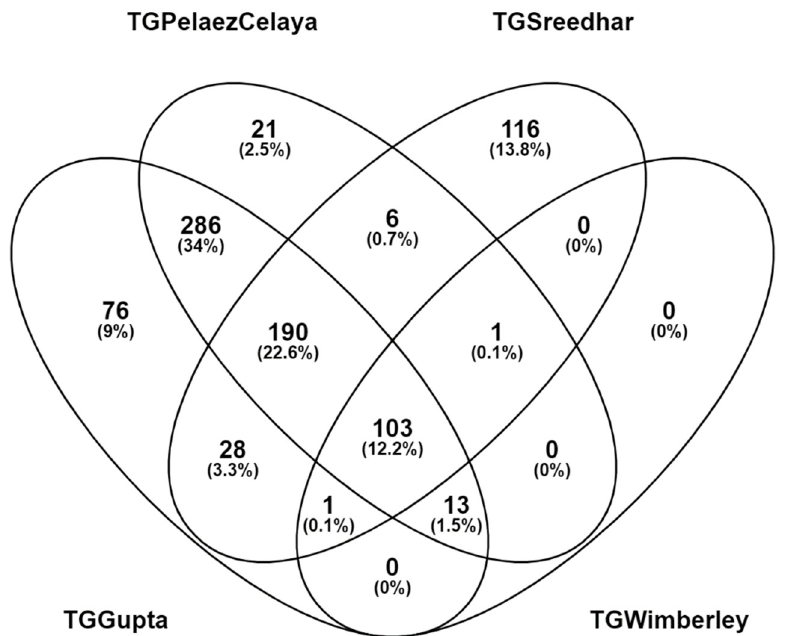
Figure 5. Different sets of peptides are identified from Aguilar-Toal á 2019 in each of the four translated assemblies. The two assemblies that incorporated seeds (TGGupta and TGPel á ezCelaya) identified the most peptides, but the assembly that added the most peptides uniquely was TGSreedhar.